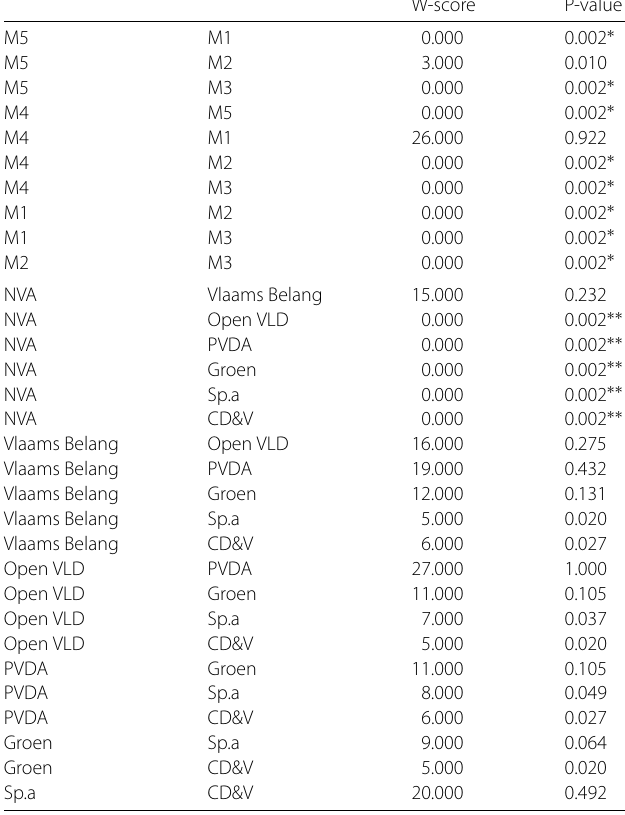
Table 9 Results for the Wilcoxon signed-rank test for party